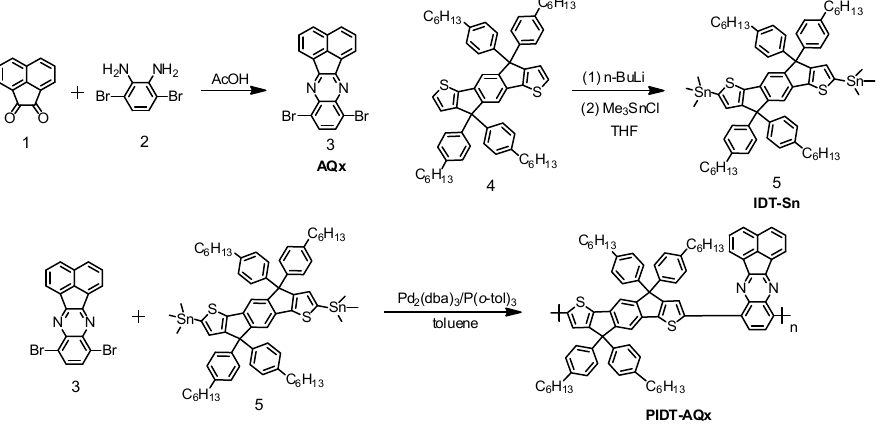
Table 1. Optical and electrochemical properties of